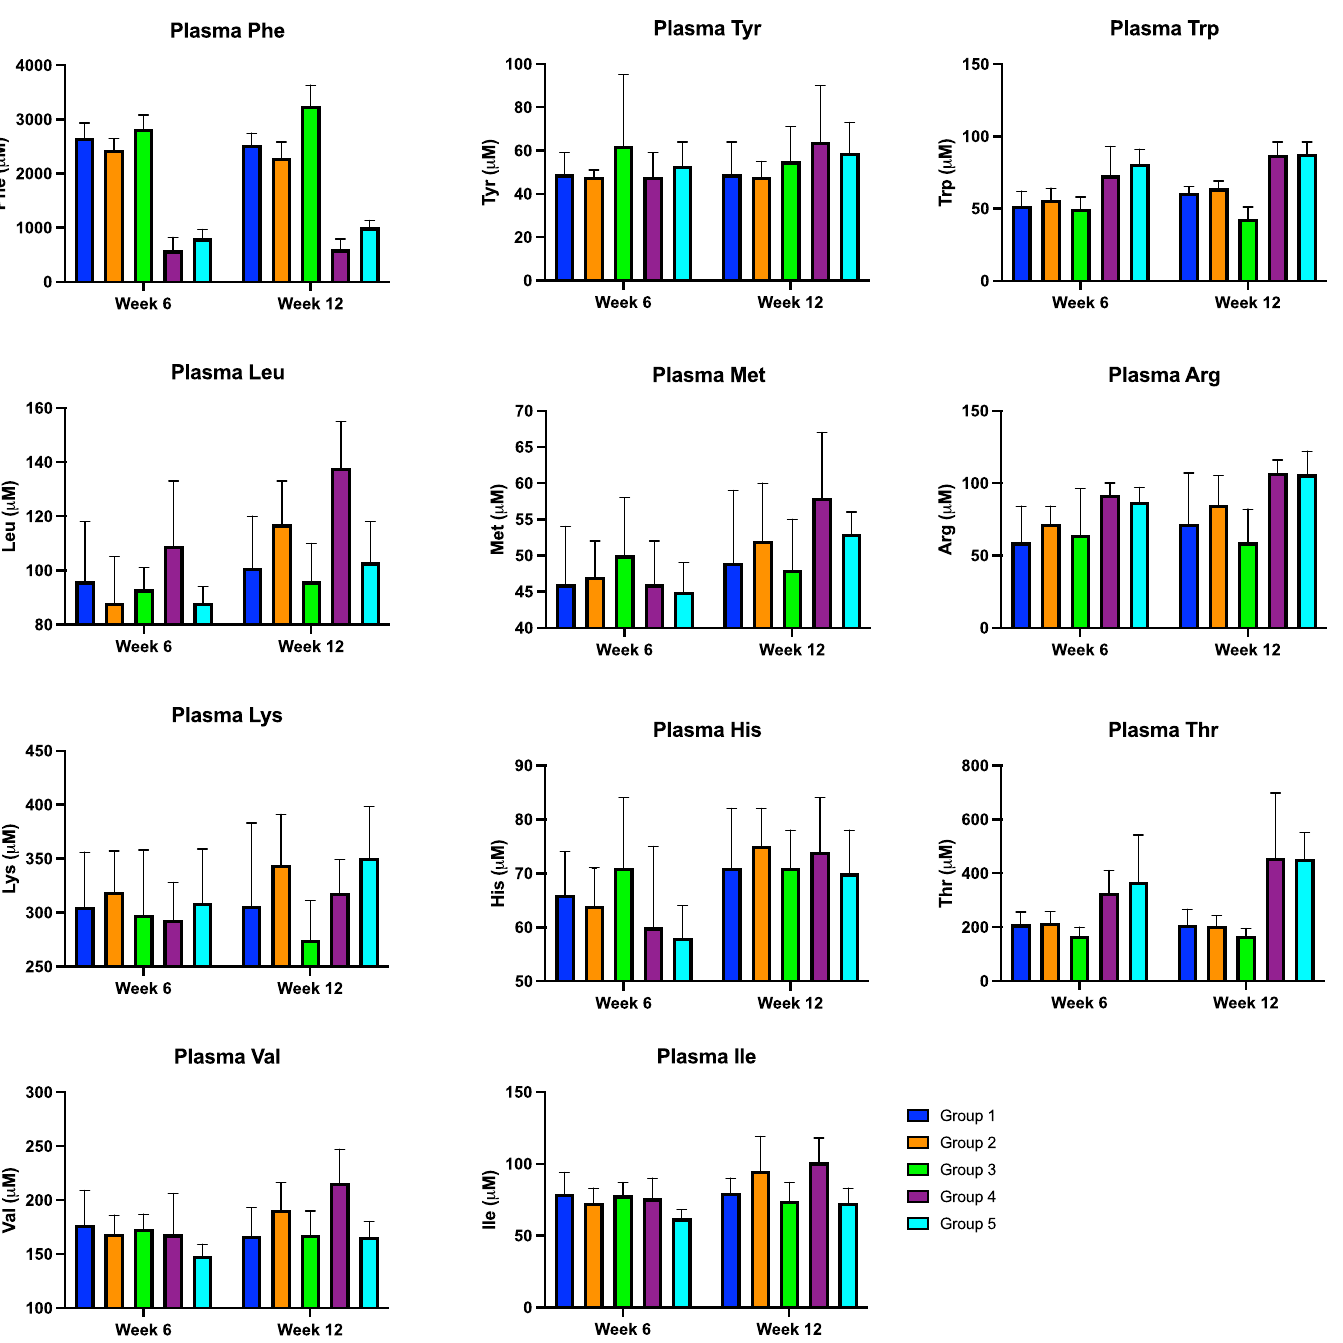
Fig 4. Average plasma concentrations of AA at w6 and w12. Group 1–5 represent: G1(N-CGMP), G2 (N-CGMP-LNAA), G3 (N), G4 (CGMP-EAA-LP) and G5 (FSAA-LP).